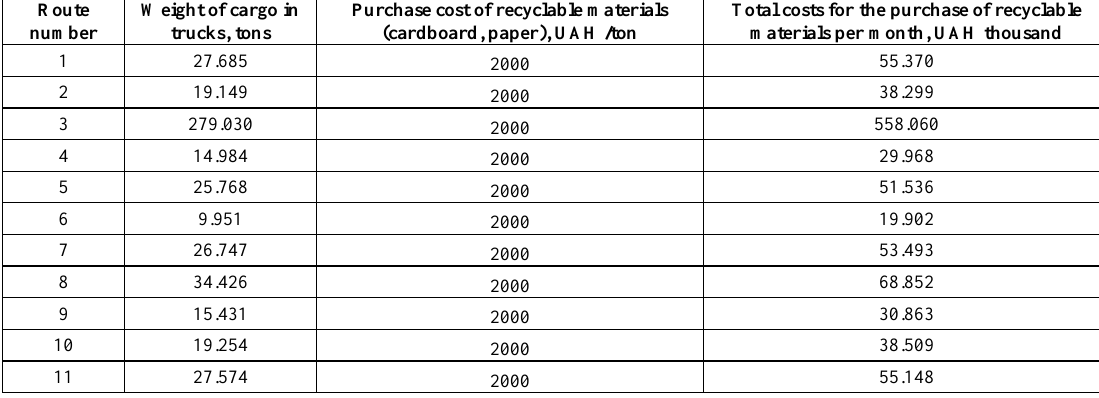
Table 3. Forecast of total costs for purchasing cardboard and paper per 1 month.